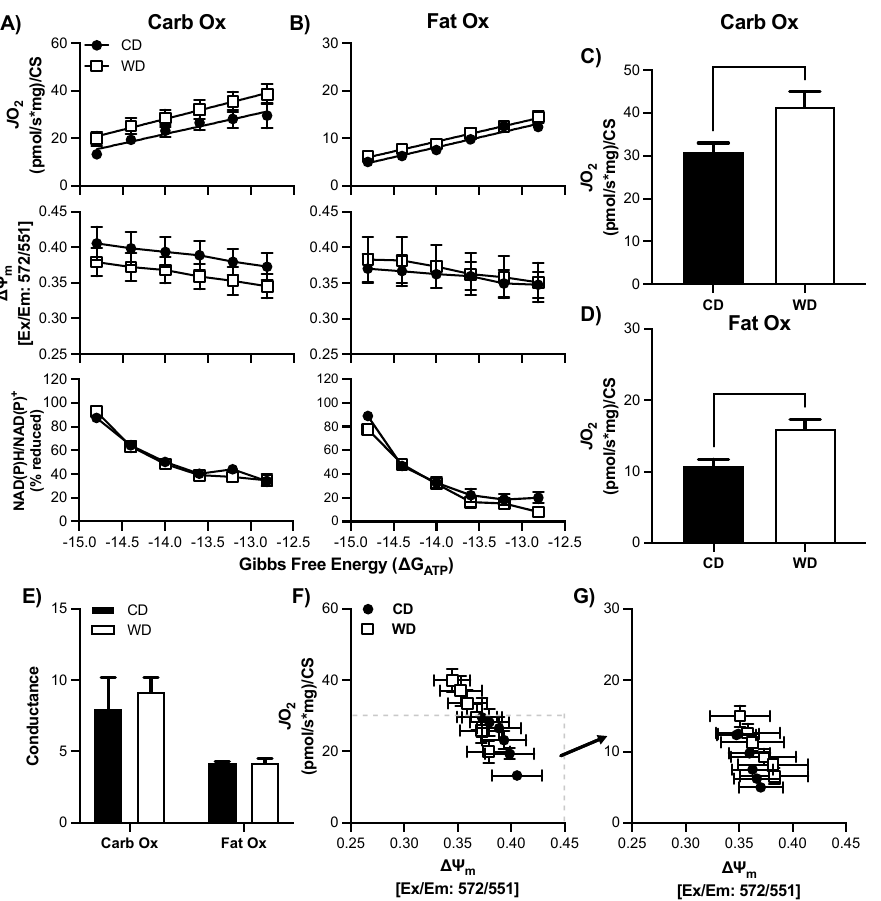
Figure 5. Respiratory control in female hypothalamic mitochondria following consumption of a Western (WD) or chow (CD) diet. ( A , B ) Changes in mitochondrial respiration ( J O 2 ), membrane potential ( ∆ ψ ), and NADH reduction state (NAD(P)H/NAD(P)+) as a function of ATP free energy ( ∆ G ATP ) and substrate: carbohydrates ( A ) and fats ( B ). ( C , D ) Maximal mitochondrial respiration for carbohydrate substrates ( C ) and fat substrates ( D ). ( E ) Conductance slopes calculated from the linear phase of J O 2 as a function of ATP free energy ( ∆ G ATP ) for carbohydrate and fat substrates. ( F – G ) Relationship between mitochondrial J O 2 and ∆ ψ in the presence of carbohydrate ( F ) or fat ( G ) substrates. Differences were analyzed by two-way ANOVA for data shown in panels A and B with factors for diet (CD vs. WD) and ATP free energy. Main effects are noted in the absence of significant interactions ( p < 0.05). Differences were analyzed by Student’s t test for panels ( C – E ).